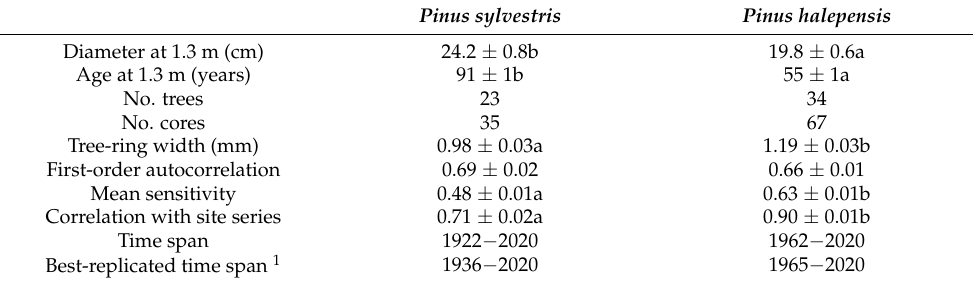
Table 1. Size and growth data of the trees sampled in the two pine plantations. Values are means ± SE. Different letters indicate significant ( p < 0.05) differences between species according to Mann–Whitney tests. Pinus sylvestris Pinus halepensis Diameter at 1.3 m (cm) 24.2 ± 0.8b 19.8 ± 0.6a Age at 1.3 m (years) 91 ± 1b 55 ± 1a No. trees 23 0.98 ± 0.03a 0.69 ±